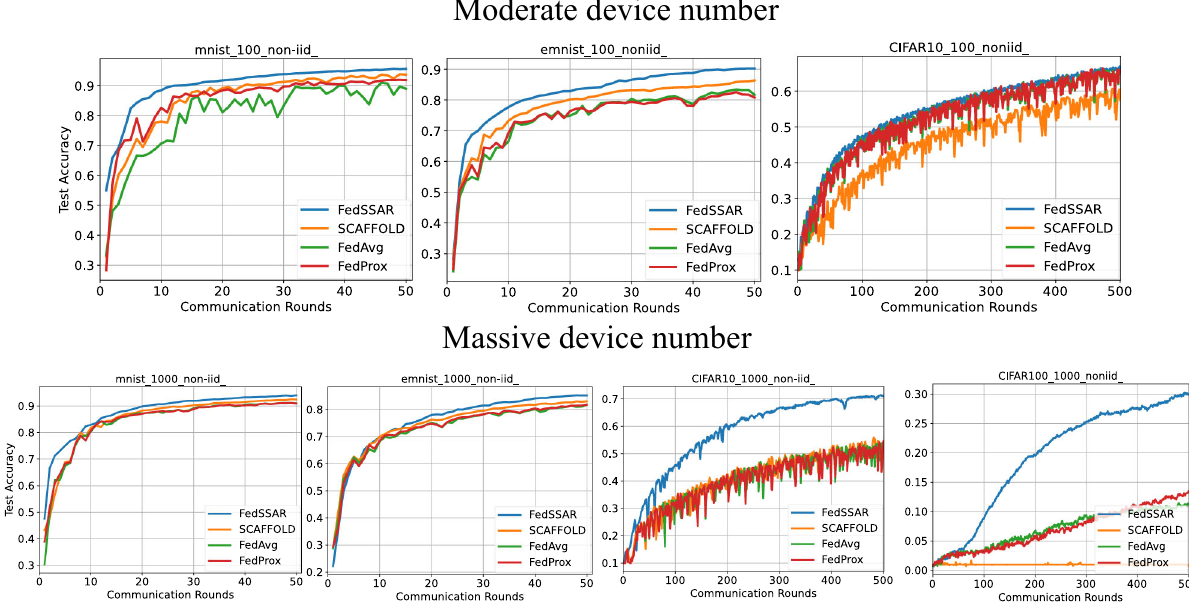
Fig. 4 Validation accuracy of FedSSAR and other methods, using decreasing learning rate η t and weight decay: 10 − 3 to achieve the best training performance during the last 50 training rounds for MNIST and EMNIST-L, 500 training rounds for Cifar-10 and